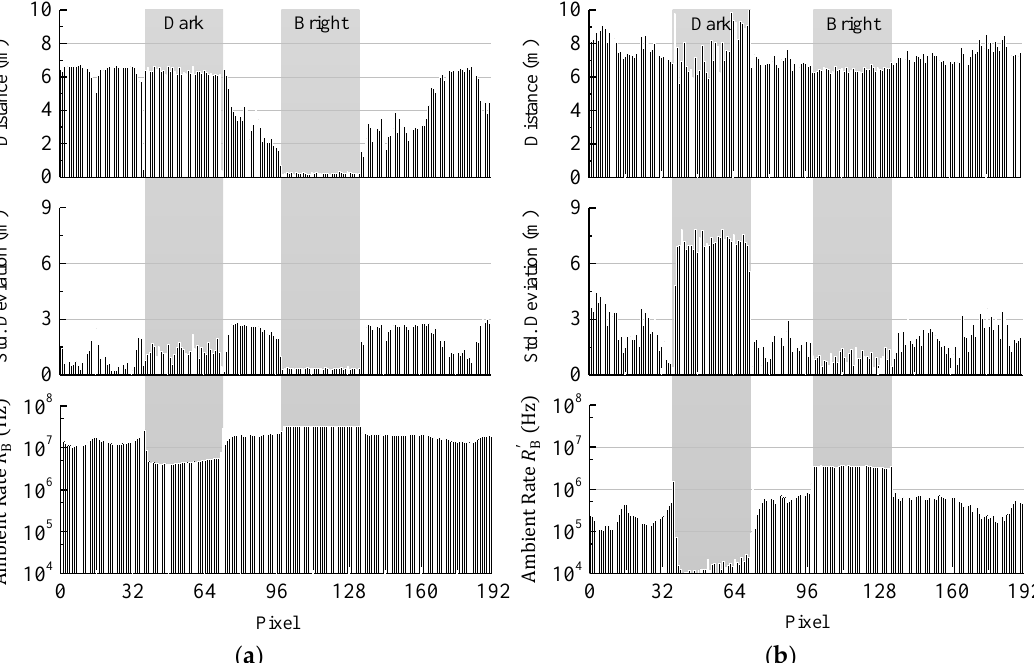
Figure 13. Mean distance, standard deviation, and ambient event rate after applying pixel-wise adaptive coincidence parameter adjustment. This allows a measurement of dark and bright targets in the same scene at once. The ambient event rates are kept at an almost constant level for all pixels.